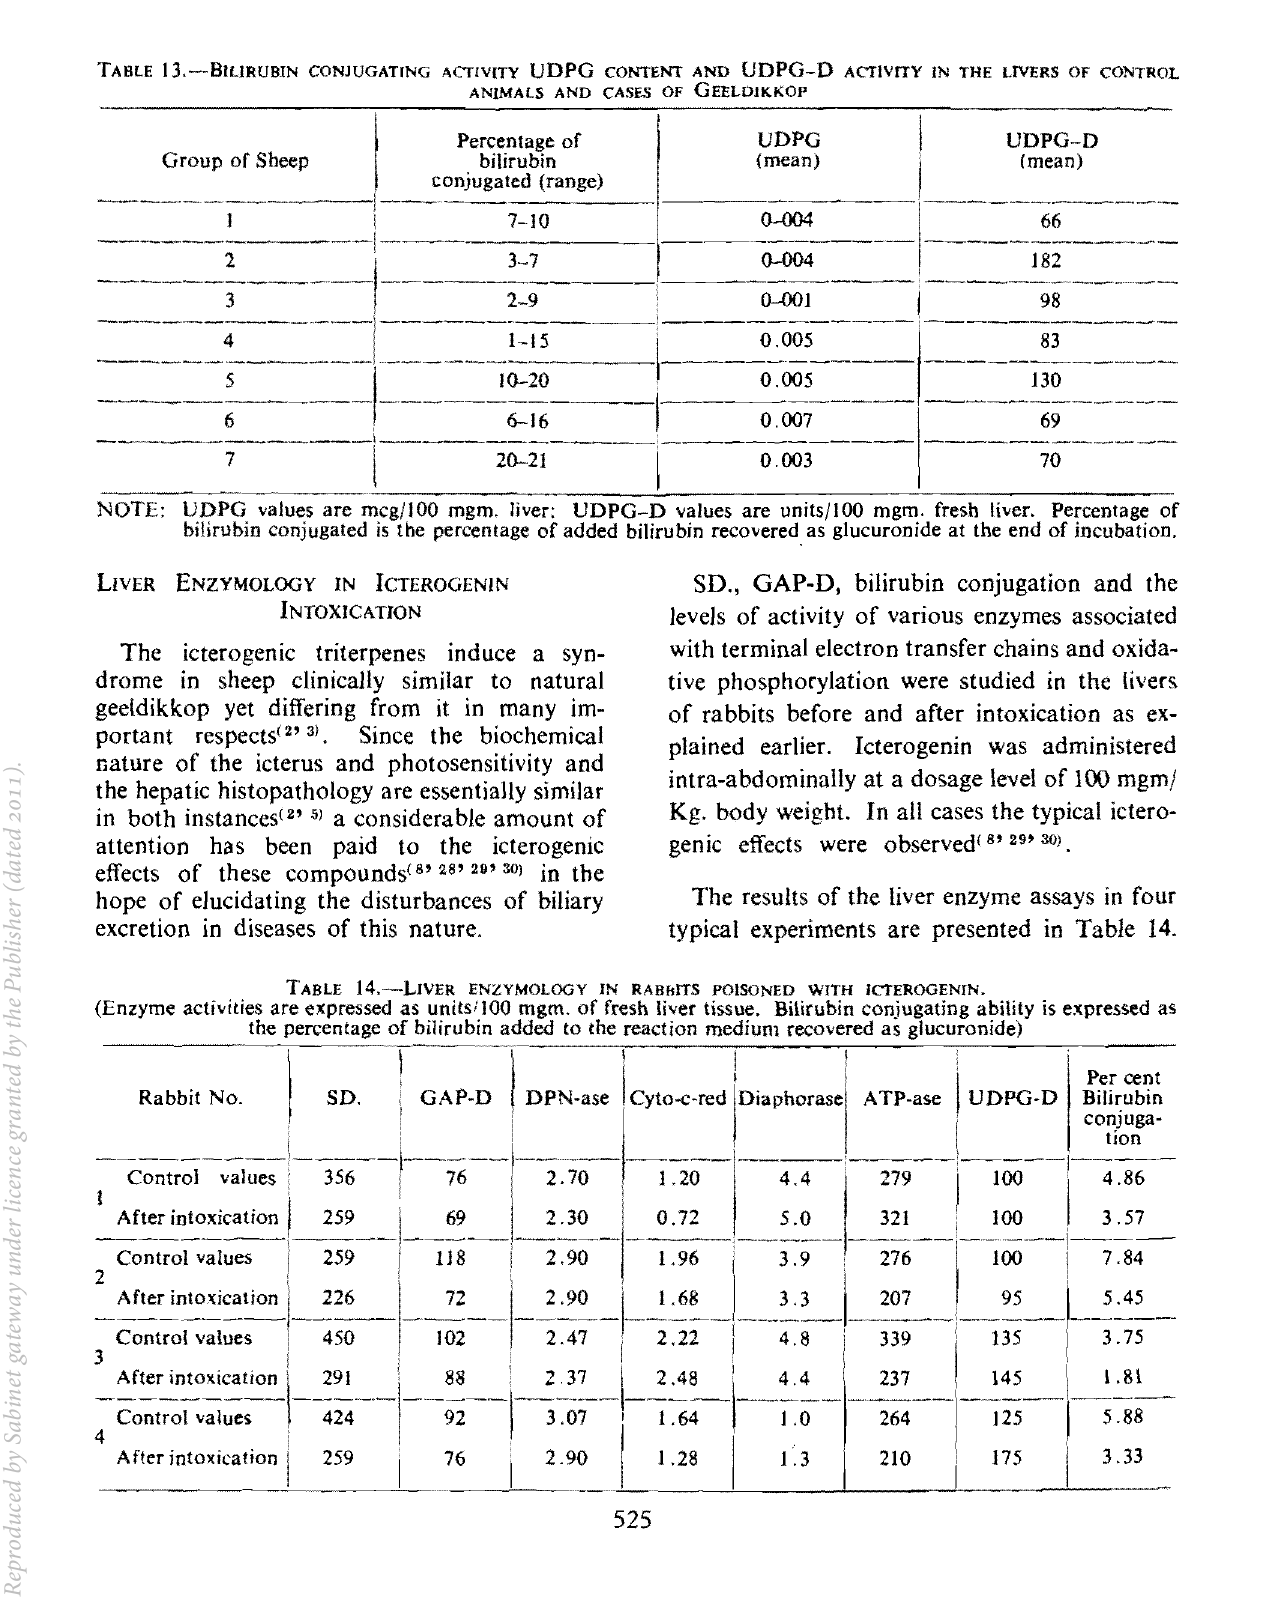
TABLE 14.-LIVER ENZYMOLOGY IN RABBITS POISONED WITH (Enzyme activities are expressed as unitsl)OO mgm. of fresh liver tissue.